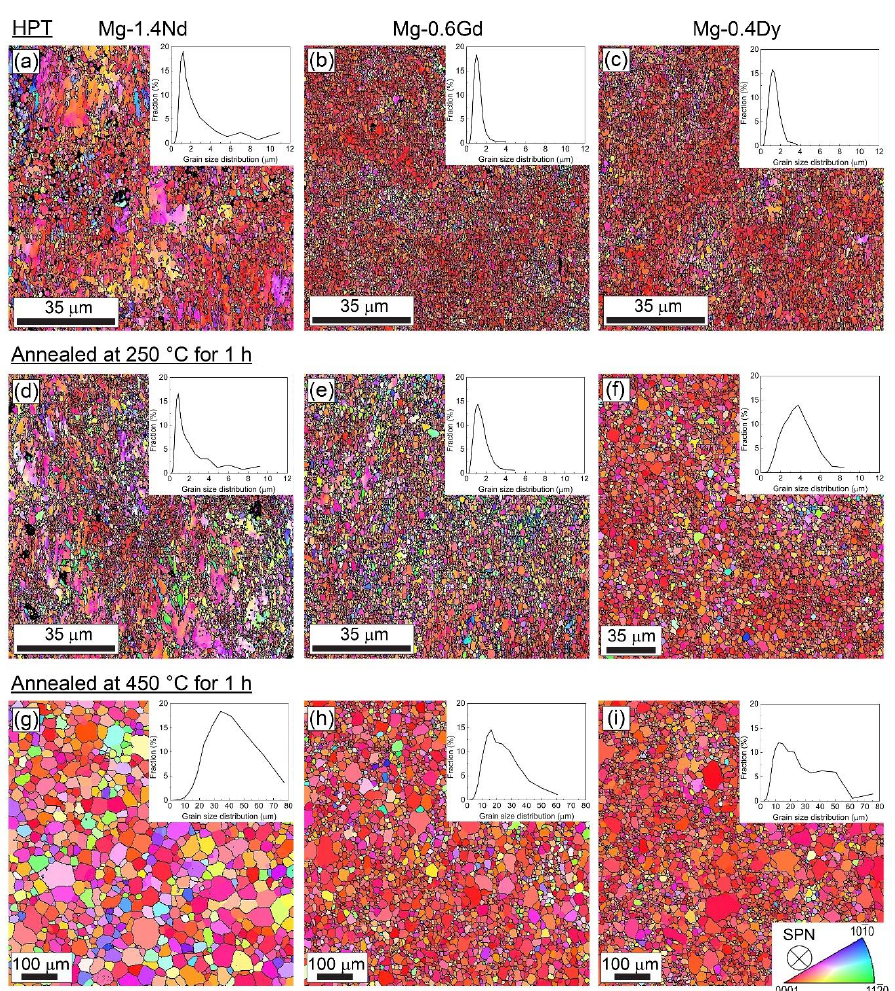
Figure 2. SPN-IPF maps and grain size distributions of HPT-processed: ( a ) Mg-1.4Nd, ( b ) Mg-0.6Gd, ( c ) Mg-0.4Dy, annealed at 250 °C for 1 h: ( d ) Mg-1.4Nd, ( e ) Mg-0.6Gd, ( f ) Mg-0.4Dy and annealed at 450 °C for 1 h: ( g ) Mg-1.4Nd, ( h ) Mg-0.6Gd, and ( i ) Mg-0.4Dy alloys. The HAGBs are indicated by a black line. SPN denotes the shear plane normal direction.